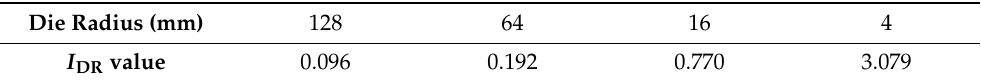
Table 2. Die radius and related I DR value used in this